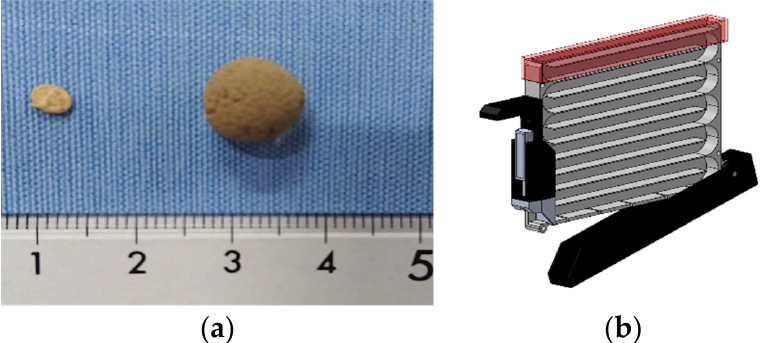
Figure 10. ( a ) a bell pepper seed and a seed ball, ( b ) CAD of a tank. A seed ball and a tank.